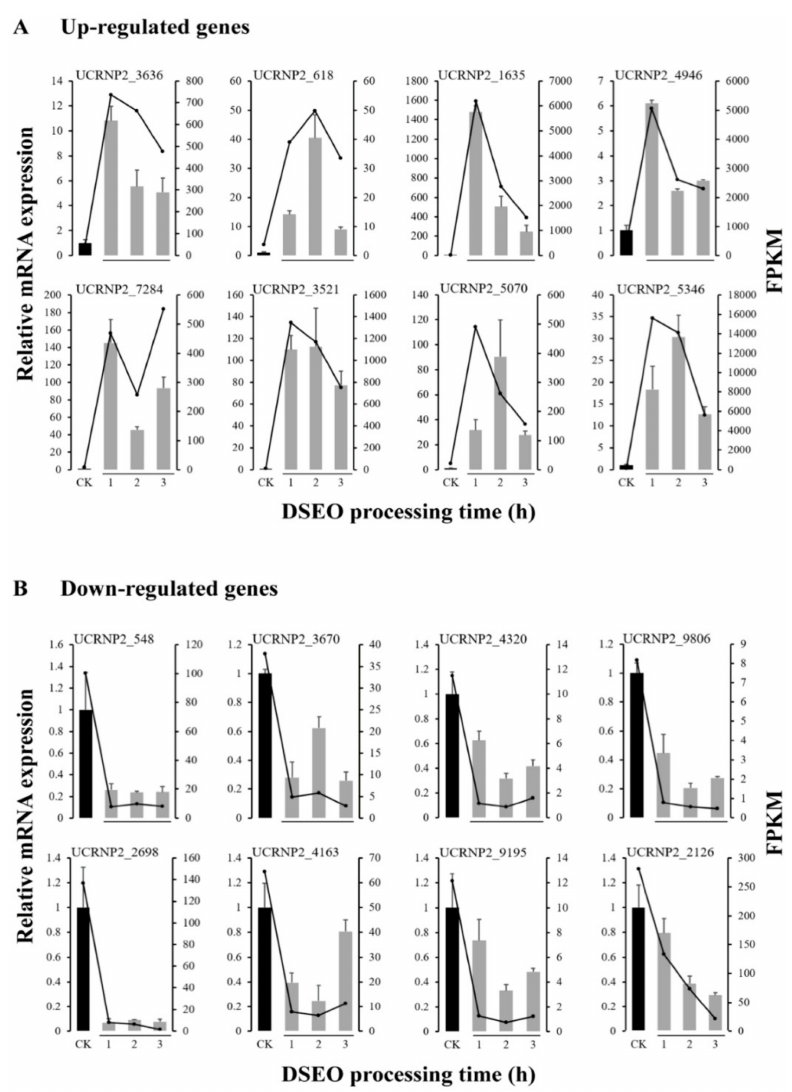
Figure 8. Validation of RNA-Seq data using qRT-PCR data of 16 selected DEGs (8 up- ( A ) and 8 downregulated ( B )). The central index axis represents relative mRNA expression, and the secondary axis represents the FPKM of genes in transcriptomics. “CK” represents